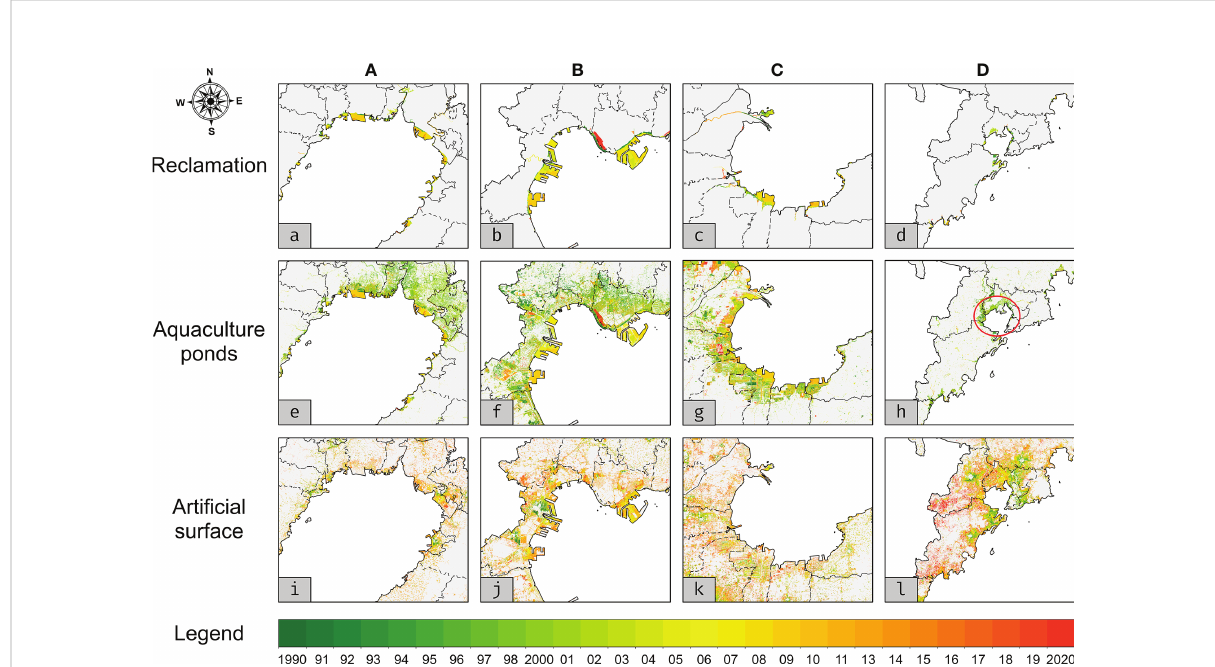
FIGURE 3 Human expansion across the Circum-Bohai Coastal Zone during the period 1990 to 2020. (a-d), Reclamation. (e-h), Aquaculture pond. (i-l), Arti fi cial surface. The four example areas are: (A) , The northern part of Liaodong Bay. (B) , The northwestern part of Bohai Bay. (C) , The southern side of Laizhou Bay. (D) , The southern part of Qingdao city. The colors represent the year when the new LU type appear, and the extent of these examples are marked as red boxes in Figure